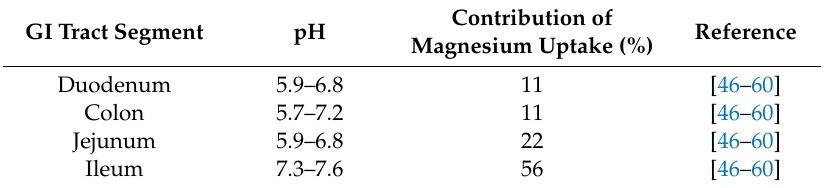
Table 1. Contribution of specific portions of the gastrointestinal tract (GI) on magnesium uptake.